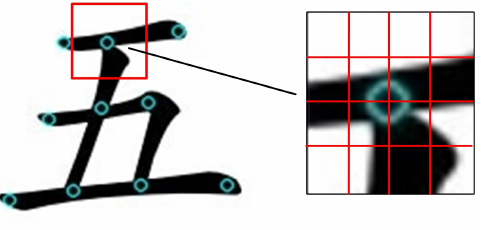
Figure 8. Information about the Feature Point neighborhood.